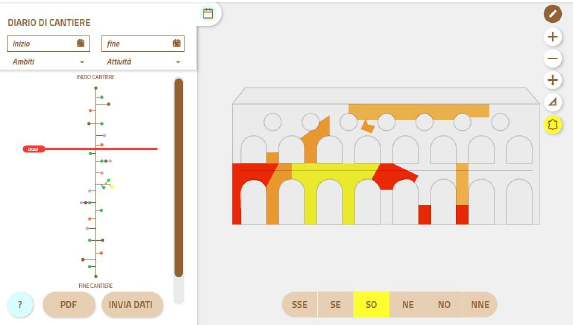
Figure 5. Plugin interface for the timeline of restoration activities designed as tool to easily check the progress of the work and graphic scheme of activities on elevations. Model: